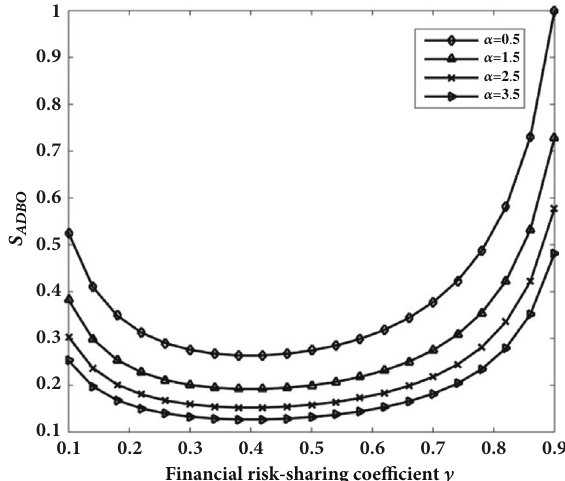
0.10.2 0.1 Figure 5: The influence of 𝛾 on 𝑆 𝐴𝐷𝐵𝑂 with different financial risk factor. (𝑉 𝑠 = 615.3857,𝑉 𝑚 = 775.5418, 𝐶 𝑠 = 285.2986, 𝐶 𝑚 = 158.0881) .